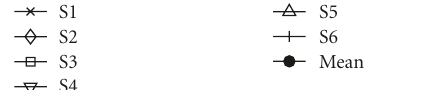
Figure 9: Speech reception thresholds (SRTs) of six cochlear implant users for noise arriving from the side ipsilateral to the behind-the-ear microphone unit.